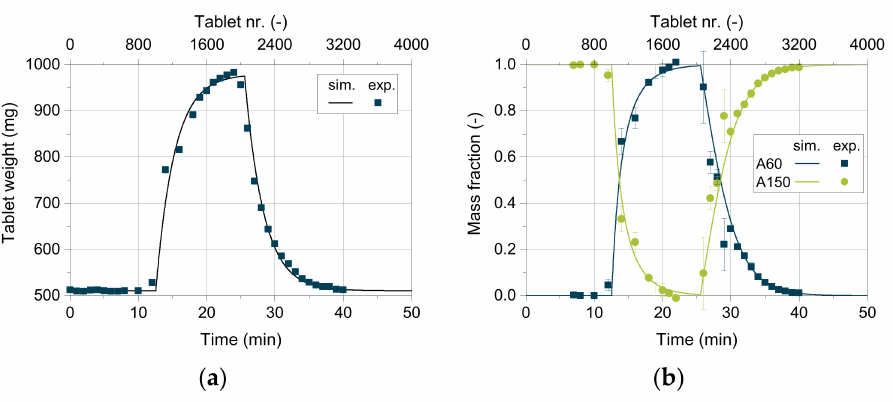
Figure 13. Comparison of the simulative data with experimental results for ( a ) the mass fraction of DCPA A150 and A60 and ( b ) the tablet